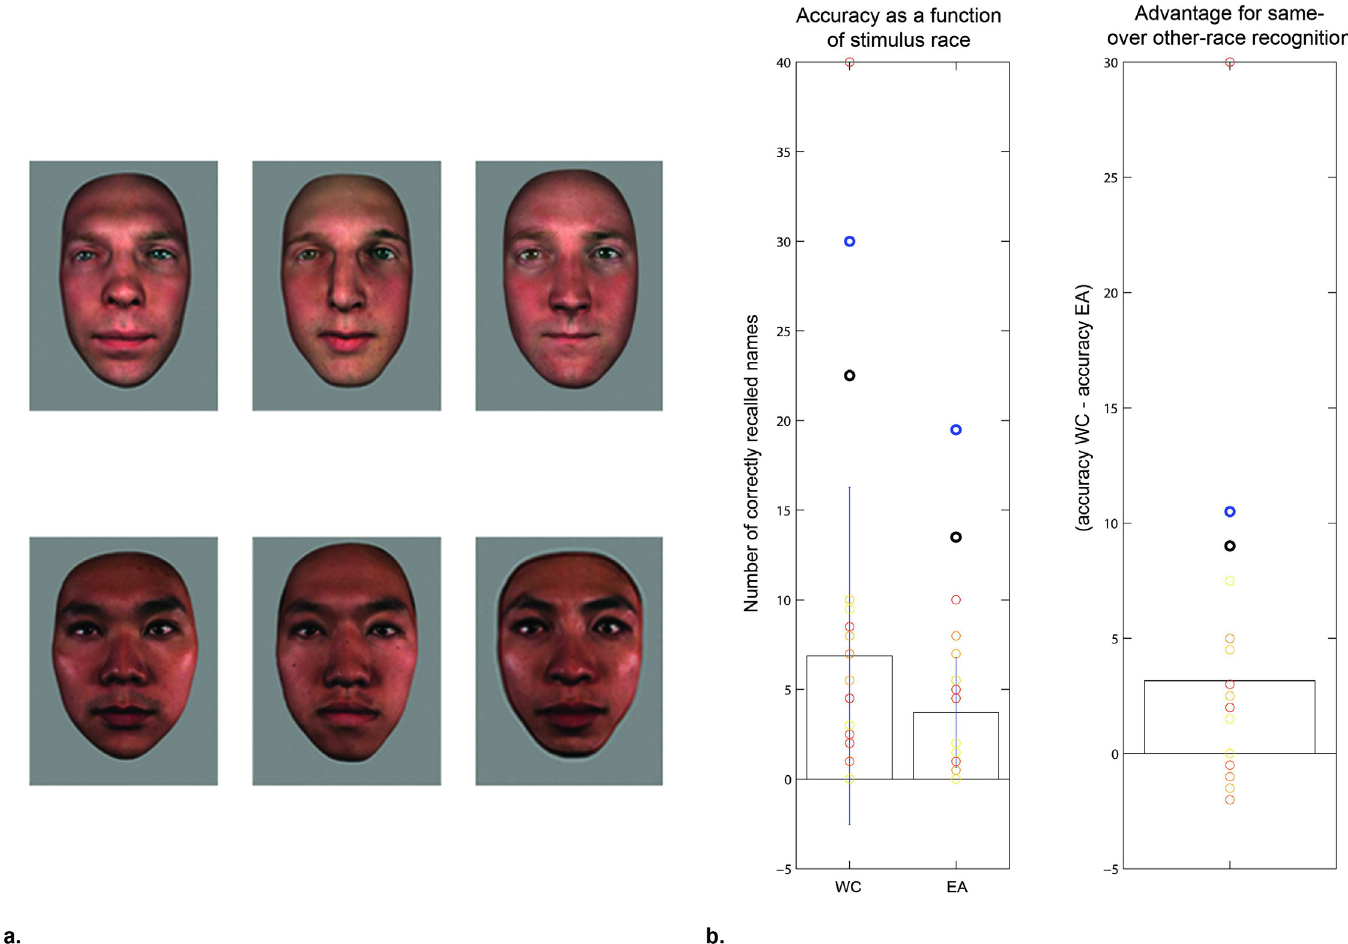
Fig 3. a. Examples of stimuli and b. results for Experiment 2: Western Caucasian and Eastern Asian face-name learning. Individual subjects ’ performance (number of correctly recalled first and/or last names) plotted as circles on top of the group (bars represent standard deviations); dark circles demonstrate SMs ’ performance (SM1: black; SM2: